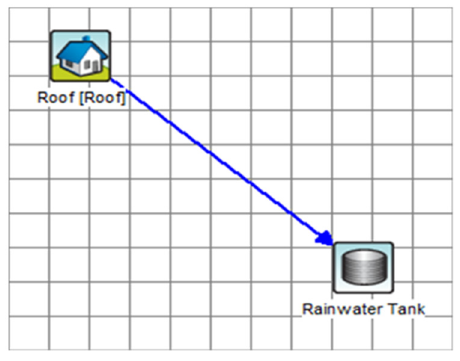
Figure 1. Model setup used in the MUSIC software.